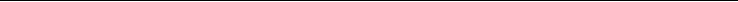
Table 4. Policy recommendations resulting from SoilCare, after